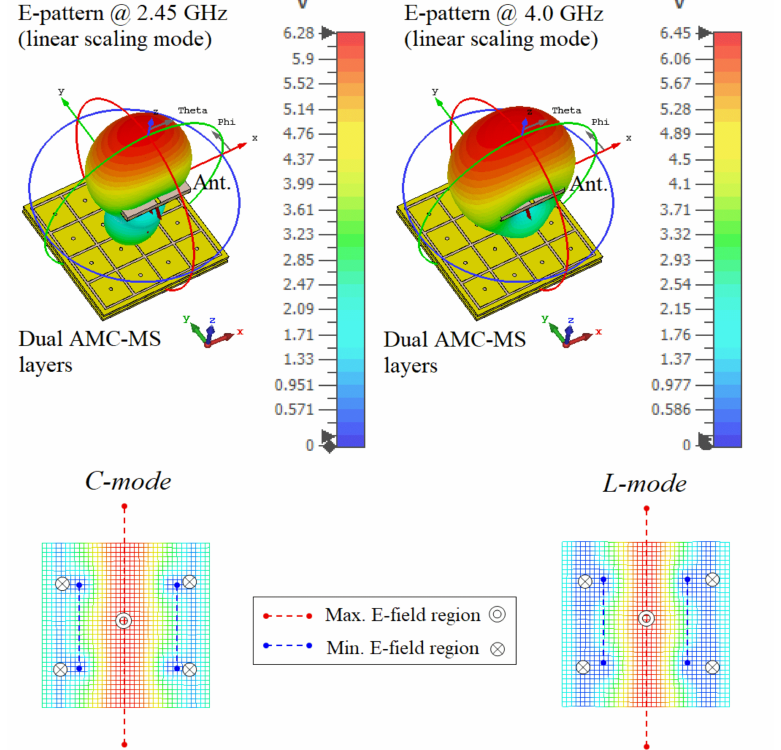
Figure 9. 3D Radiation patterns and magnitude of radiated E-field intensity for C-mode at 2.45 GHz and L-mode at 4.0